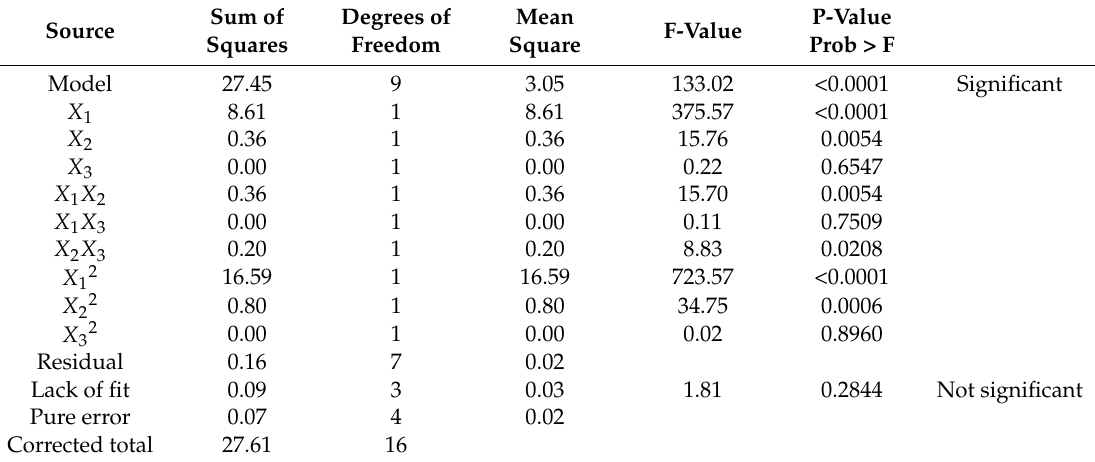
Table 6. Analysis of variance (ANOVA) of the abrasive ratio for the selected experimental correlation using